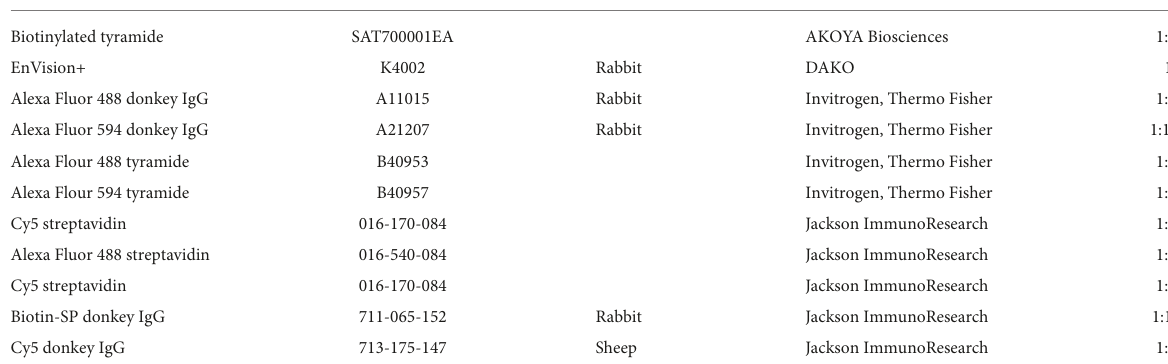
TABLE 2 Secondary antibodies. Antibody